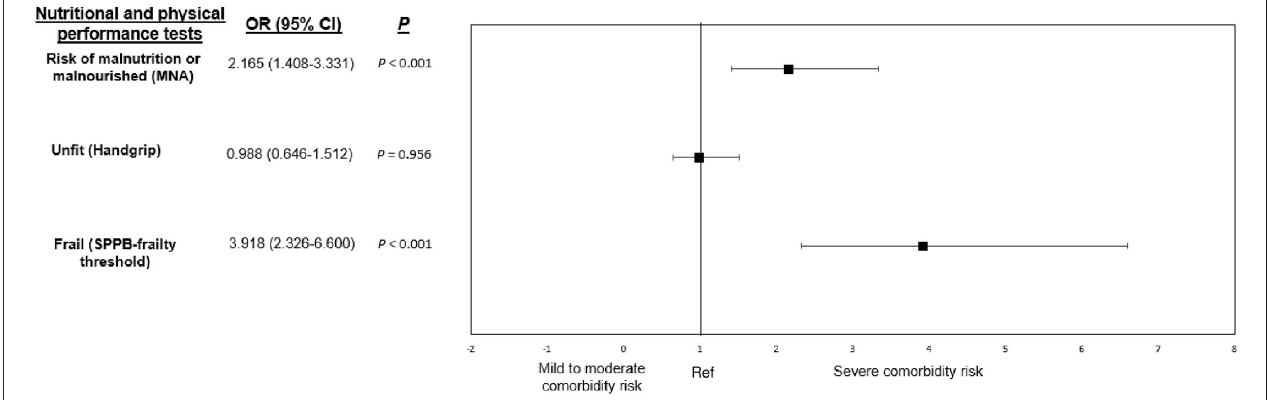
FIGURE 2 | Odd ratios and 95% confidence intervals (95% CI ) for being classified as at severe comorbidity risk [CCI ≥ 5, (32)] according to the nutritional status (MNA-SF) and different performance-based physical tests (handgrip and SPPB). MNA-status, Mini Nutritional Assessment-status; SPPB-frailty threshold, Short Physical Performance Battery-frailty threshold. Unadjusted odds ratios. Nutritional assessment by the Mini Nutritional Assessment-Short Form questionnaire (scores ≤ 11 at risk of malnutrition or malnourished); handgrip unfit assessment according to Dodds et al. (36) percentiles ( ≤ P25 unfit); frailty assessment according to the Short Physical Performance Battery frailty threshold (scores ≤ 9 frail). Ref: scores > 11 normal nutritional status; > P25 fit; scores > 9